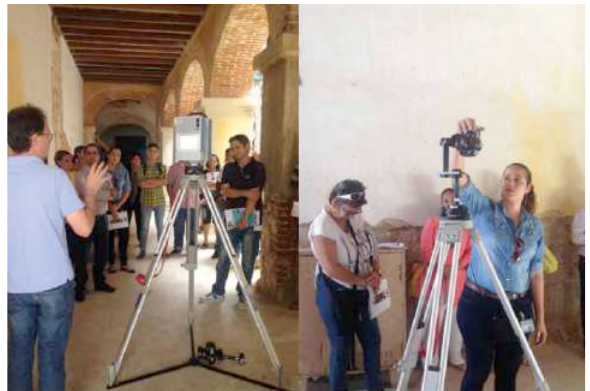
Figure 4. Laser scanner survey REDI centre, L’Havana (Raschieri, Cuba04, 2017)